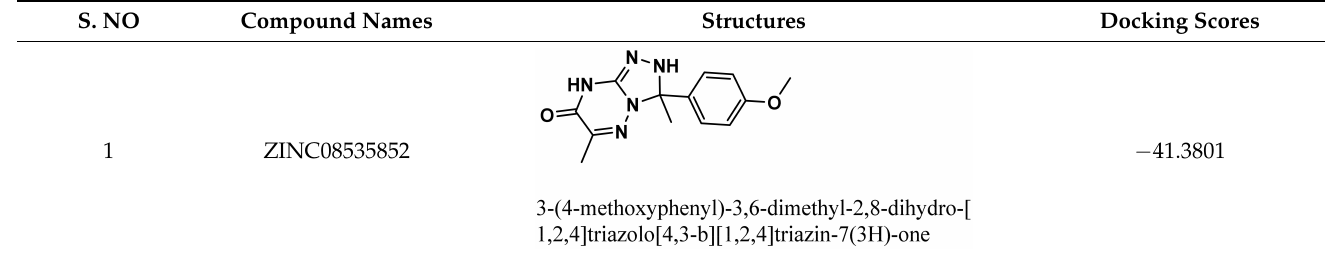
Table 1. The finalized lead hit compounds’ 2D structures and docking